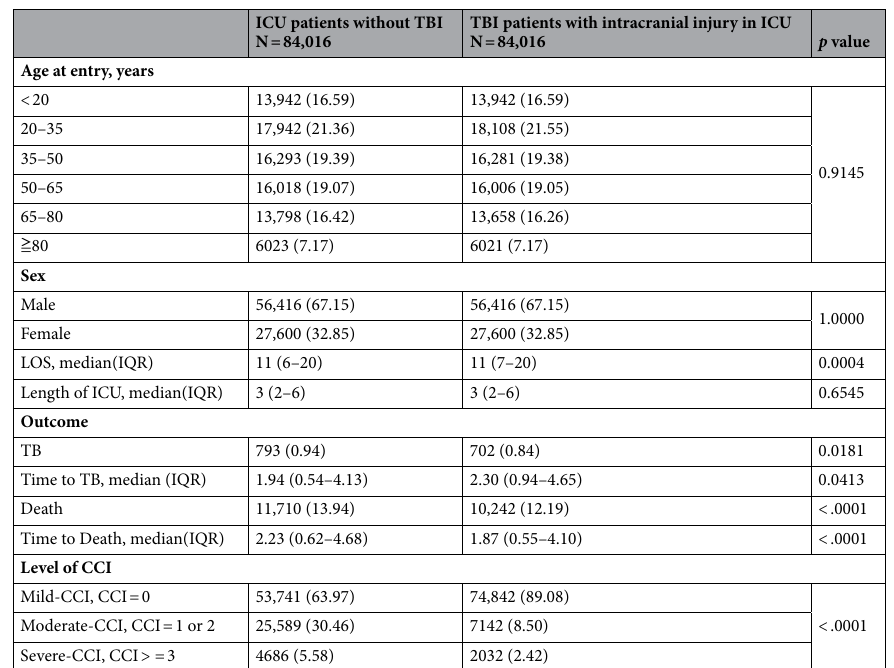
Table 1. The baseline information of patients without TBI and with intracranial injury in ICU. CCI Charlson’s comorbidity index, ICU intensive care unit, LOS length of stay, SD standard deviation, TBI traumatic brain injury.